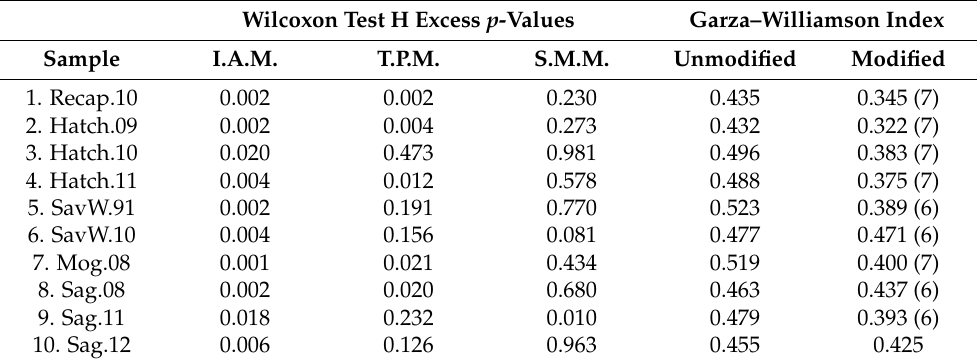
Table 2. Output of Bottleneck analysis, showing probability ( p ) of heterozygote excess of the studied samples compared with three different models (I.A.M, T.P.M. and S.M.M.), and unmodified and modified Garza–Williamson index (number of loci with modified index < 0.68 in